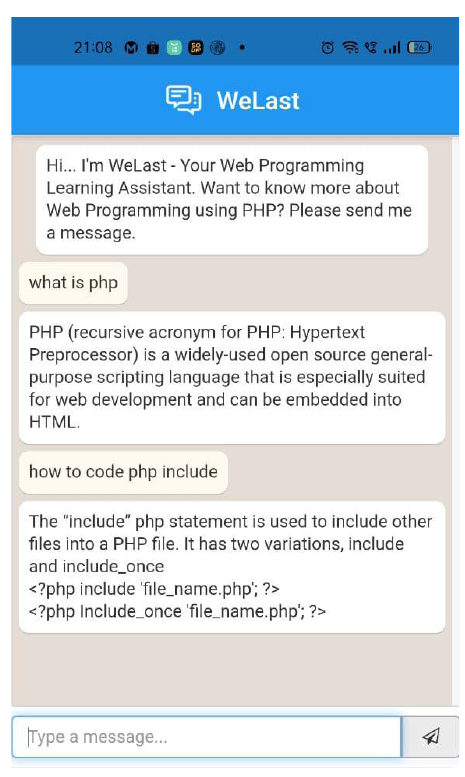
Fig. 4. Chatbot mobile application for Android